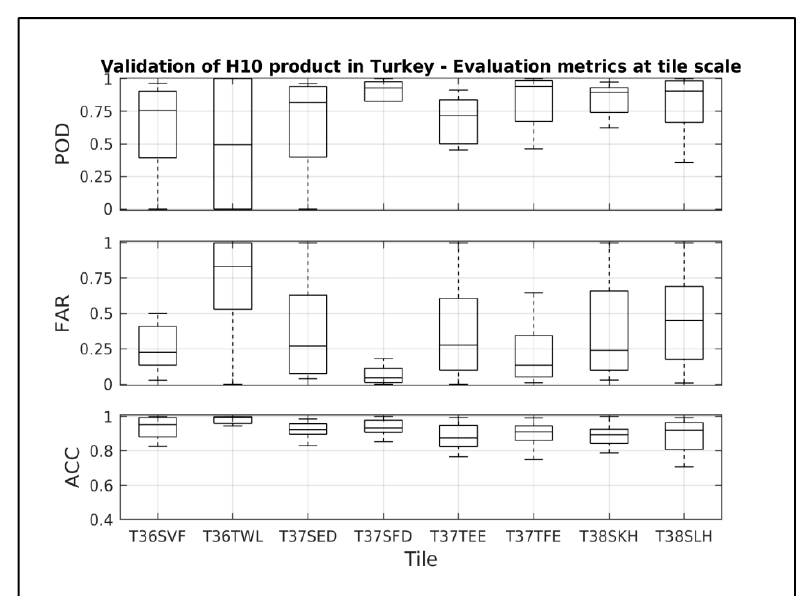
Figure 15. Evaluation metrics at tile scale in Turkey.